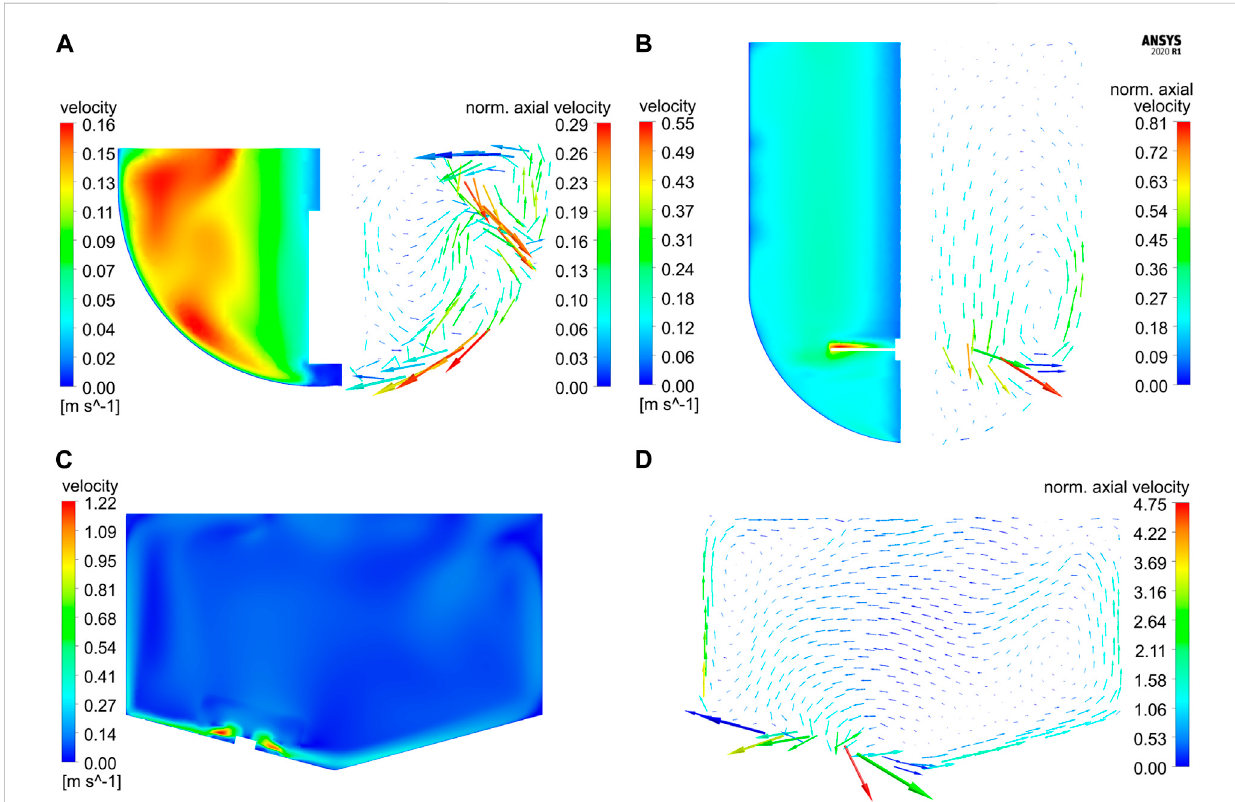
FIGURE 3 Contour plots of the velocity magnitude vs projected velocity vector plots colored according to the axial velocity magnitude (normalized to the respective average velocity magnitude in each reactor) on vertical cut planes for (A) GST-1 (60 rpm), (B) GST-2 (60 rpm) and (C – D) SUM (400 rpm). Due to the symmetrical design of GST-1 and -2, half of the plots are shown side-by-side. Please note that the vector length corresponds to the velocity magnitude in each reactor but was scaled individually for each plot and, therefore, is not comparable among the